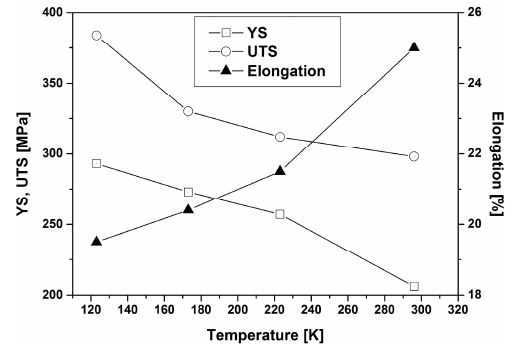
Figure 2. Temperature dependence of the tensile properties of ZK60 (after [4]).